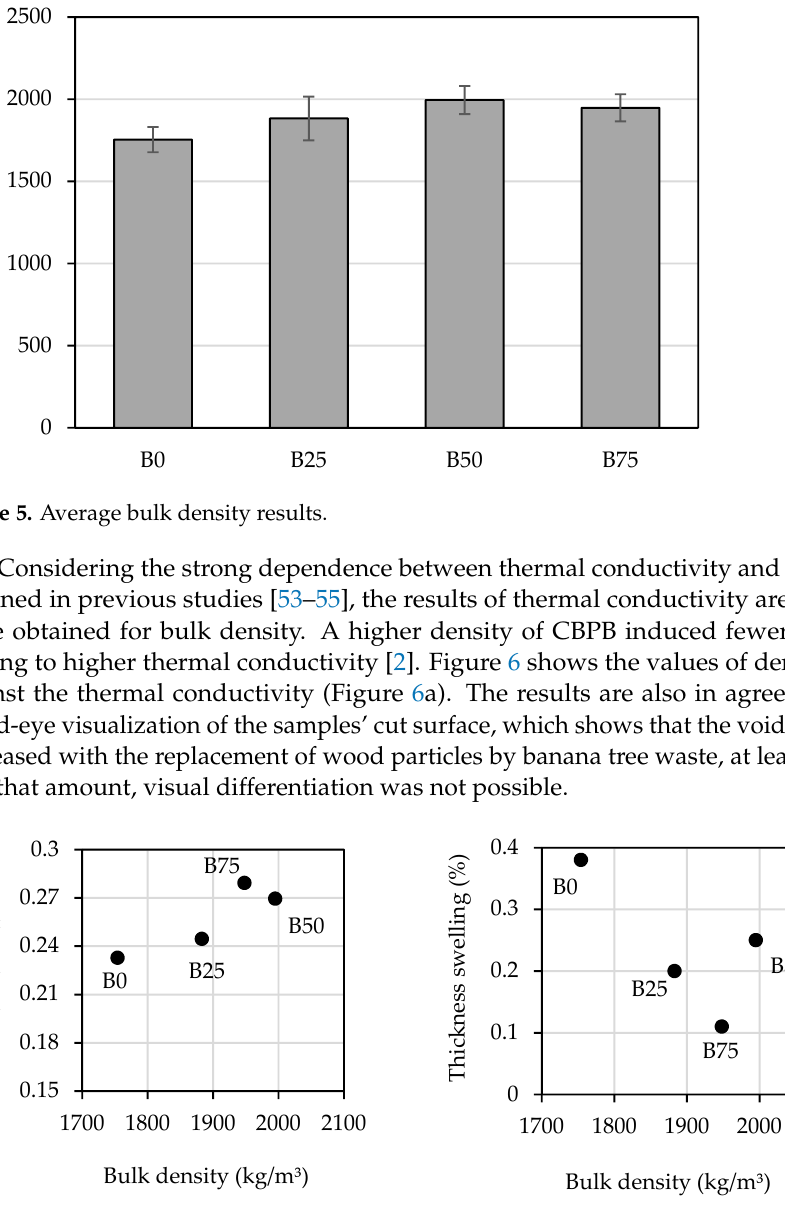
Figure 5. Average bulk density results.